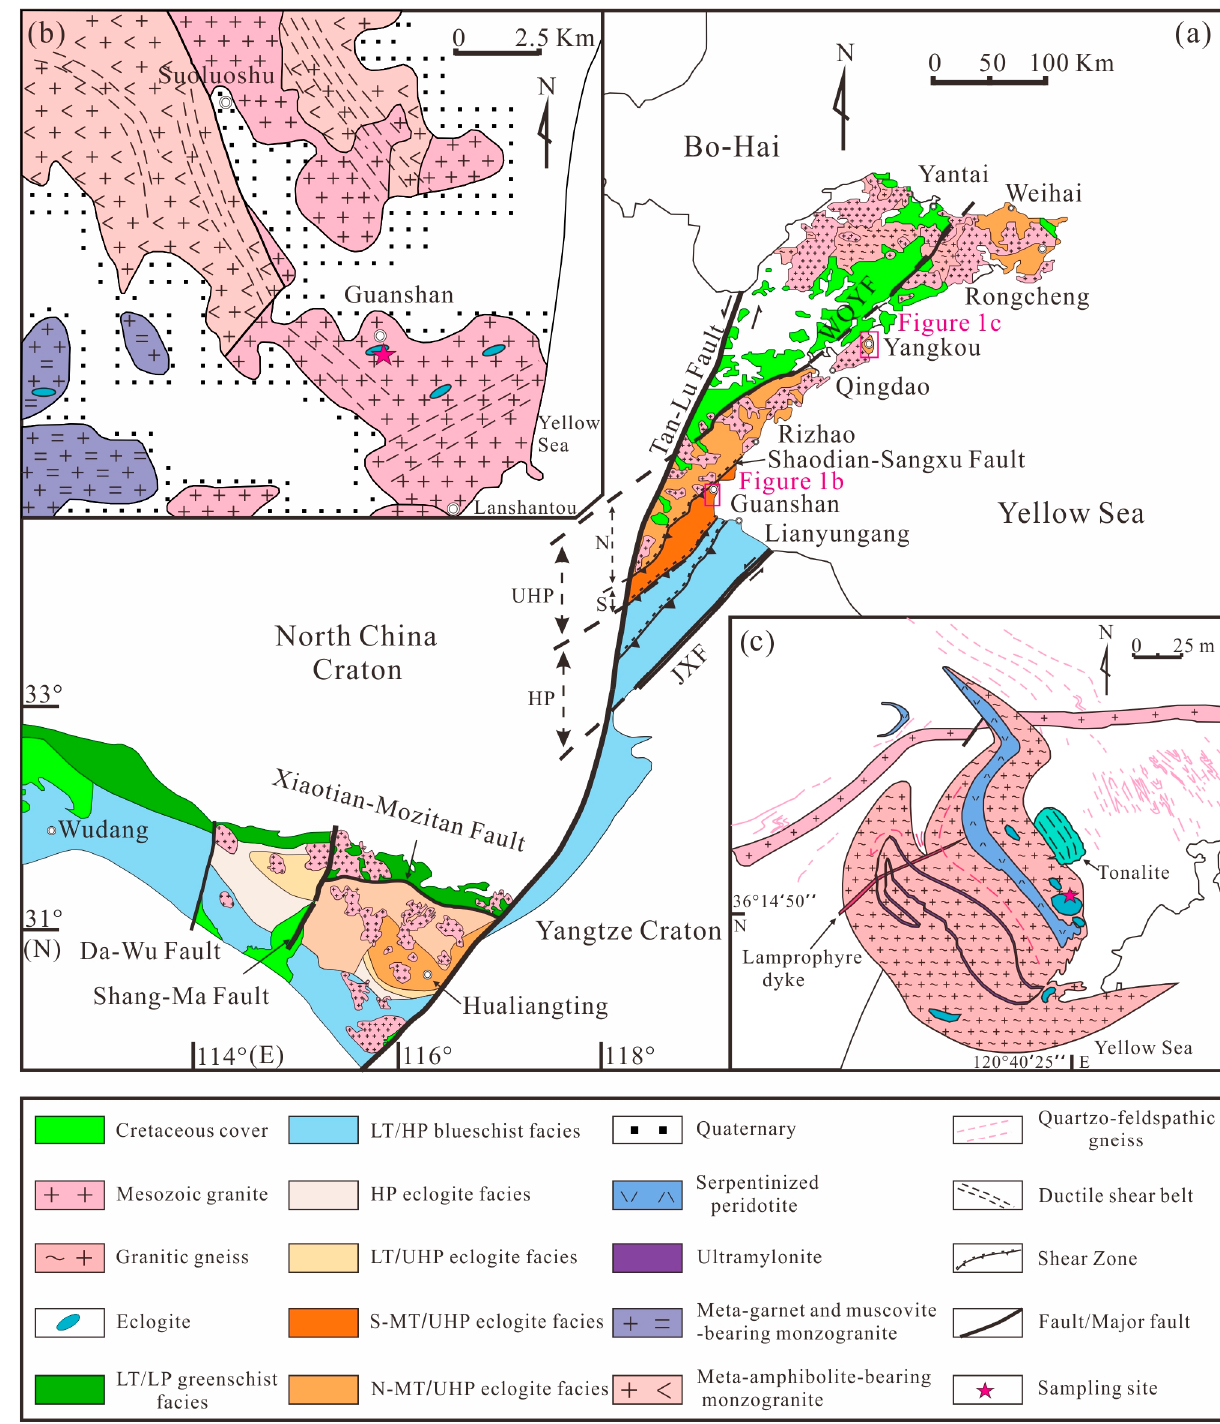
Figure 1. ( a ) Geological sketch map of the Dabie-Sulu orogenic belt in eastern China (modified after [19,38]). Geological map of the Guanshan area ( b ) and Yangkou area ( c ) (modified after [5,36,38]), showing lithological distribution and sampling locations.